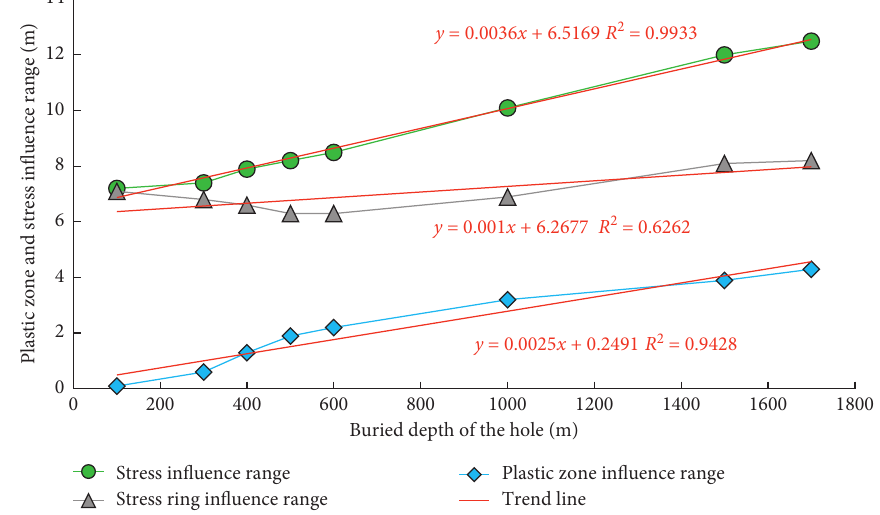
Figure 11: Relation between plastic zone range and stress influence range of straight wall semicircular arch